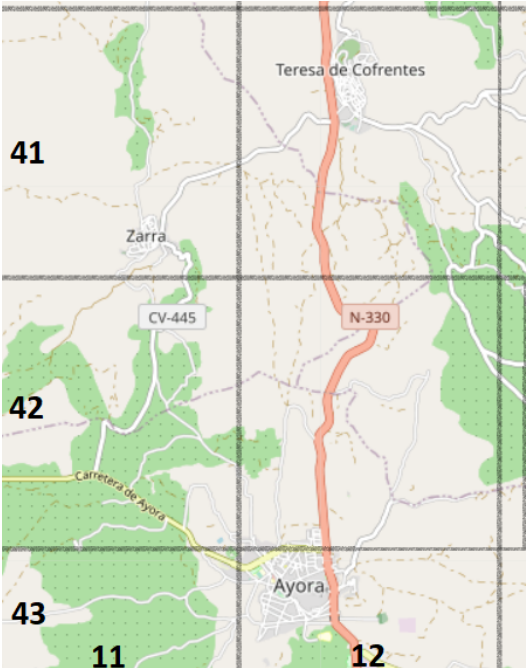
Figure 3. Small part of the province divided as the matrix P would do. The numbers at the bottom indicate the column numbers and those on the right the row numbers. Painted in red, there is the road linking two villages: Ayora and Teresa de